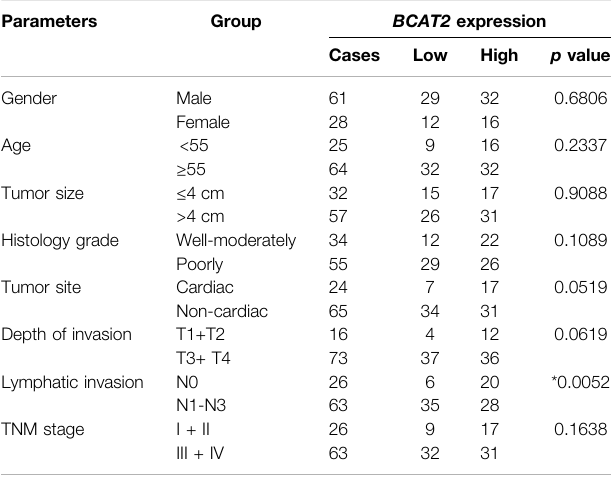
TABLE 1 | Relationships between BCAT2 expression and clinical-pathological parameters in gastric cancer.